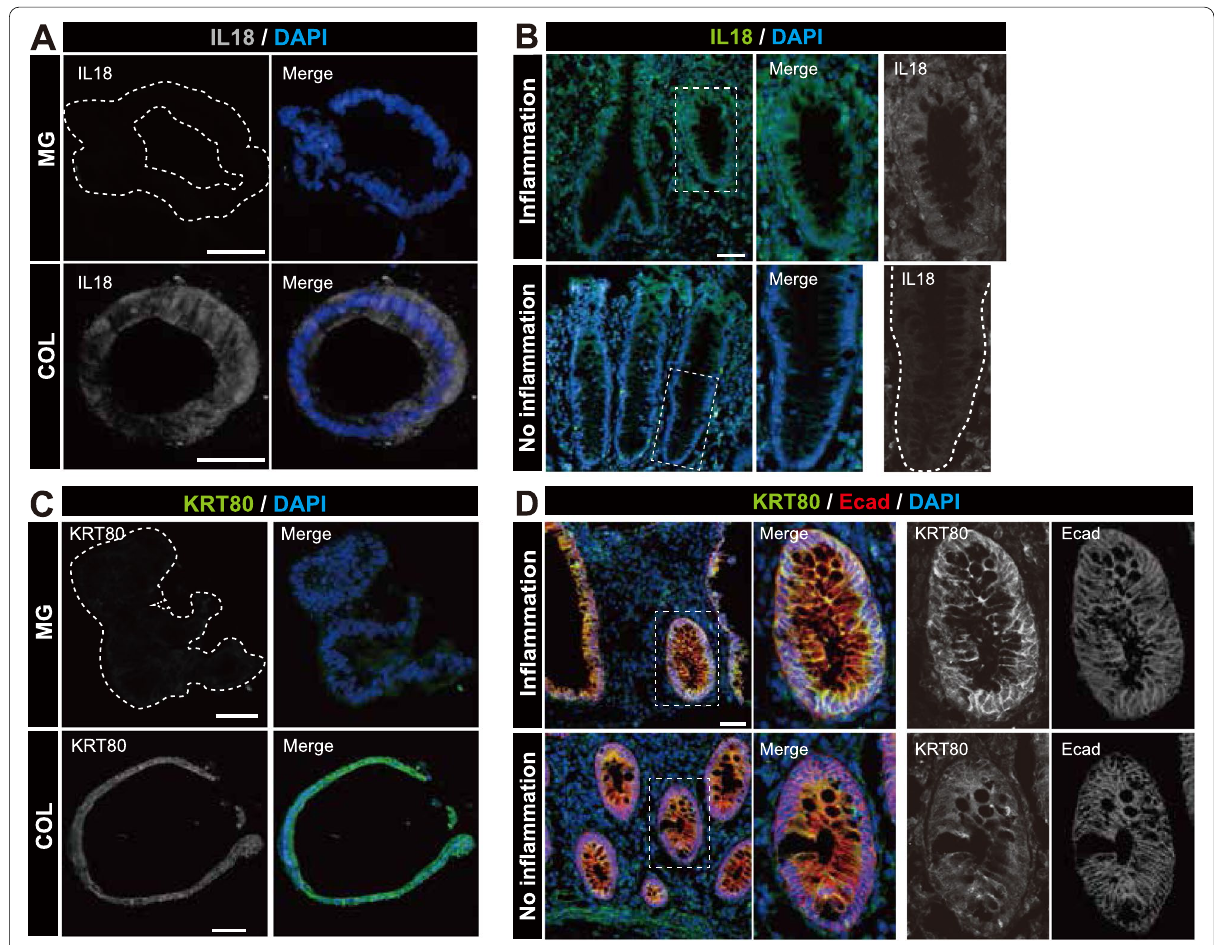
Fig. 6 Histological validation of human COL gene set. A Immunofluorescence images of Il18 (gray) of human colonic organoids in Matrigel (MG, top) and in collagen (COL, bottom) are shown. In MG panel, the region of organoids is indicated with a dashed while line. In the right panels, merged images with DAPI (blue) are shown. Scale bars, 50 μm. B Immunofluorescence images of IL18 (green) in surgical specimen from inflamed (inflammation) and non‑inflamed (no inflammation) regions of ulcerative colitis are shown. Images are counterstained with DAPI (blue). The insets magnify areas indicated by a dashed square with staining of IL18 (gray) alone. A white dashed line in an enlarged gray image of non‑inflamed region indicates a crypt/lamina propria boundary. Scale bar, 50μm. C Immunofluorescence images of KRT80 (gray) of human colonic organoids in Matrigel (MG, top) and in collagen (COL, bottom) are shown. In MG panel, the region of organoids is indicated with a dashed white line. In the right panels, colored images (green) counterstained with DAPI (blue) are shown. Scale bars, 50 μm. D Immunofluorescence images of KRT80 (green) in surgical specimen from inflamed (inflammation) and non‑inflamed (no inflammation) regions of ulcerative colitis are shown. Images are counterstained with E‑cadherin (red) and DAPI (blue). The insets magnify areas indicated by a dashed square with the staining of KRT80 (gray) and E‑cadherin (gray) alone. Scale bar,